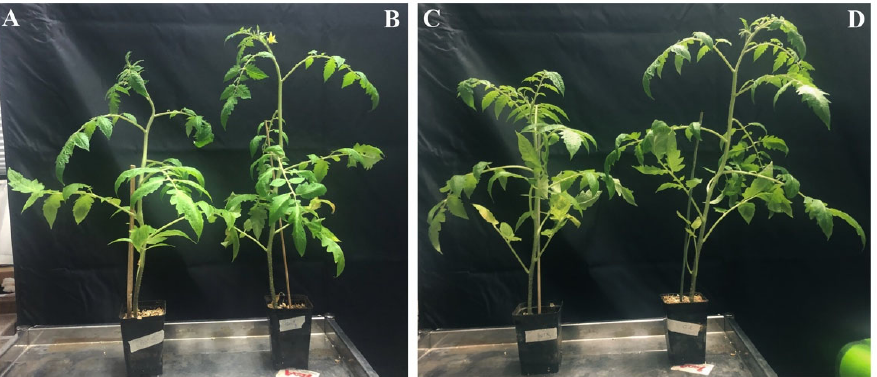
Figure 8. In vivo effect of OLE-loaded CTNPs on the growth state of tomato plants. ( A ) Plants inoculated with V. dahliae for 10 days (positive CTR); ( B ) non-inoculated plants (negative CTR). Plants inoculated with V. dahliae for 10 days and treated with OLE-loaded CTNPs; ( C ) at a concentration of 0.71 mg/mL and ( D ) at a concentration of 1.41 mg/mL.